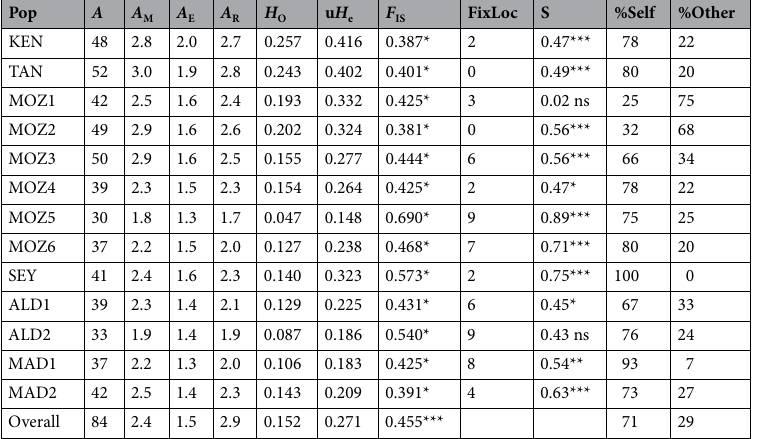
Table 2. Genetic diversity measures of 13 Rhizophora mucronata populations of the Western Indian Ocean. Highest levels of allele diversity can be found in East Africa (KEN and TAN). Inbreeding is present in all populations with highest levels on the small remote islands (SEY, ALD1 and ALD2). A high number of monomorphic and fixed loci were apparent in southern Africa (MOZ5 and MOZ6) and remote locations (ALD1, ALD2 and MAD1). Estimated selfing rates were generally high. MOZ1 and MOZ2 individuals can be assigned to other populations whereas individuals from SEY were assigned solely to their own population. Total number of alleles ( A ), mean number of alleles ( A M ), effective number of alleles ( A E ), allelic richness at k = 34 gene copies ( A R ), observed heterozygosity ( H O ), unbiased expected heterozygosity (u H e ) heterozygosity, inbreeding coefficient ( F IS ), number of loci fixed as homozygotes for one or more allele (FixLoc), selfing rate (S), percentage of individuals assigned to own population (%Self) and percentage of individuals assigned to any other population (%Other). Significance levels are indicated as follows: *** significant at p < 0.001, ** significant at p < 0.01, * significant at p < 0.05, and ns: not